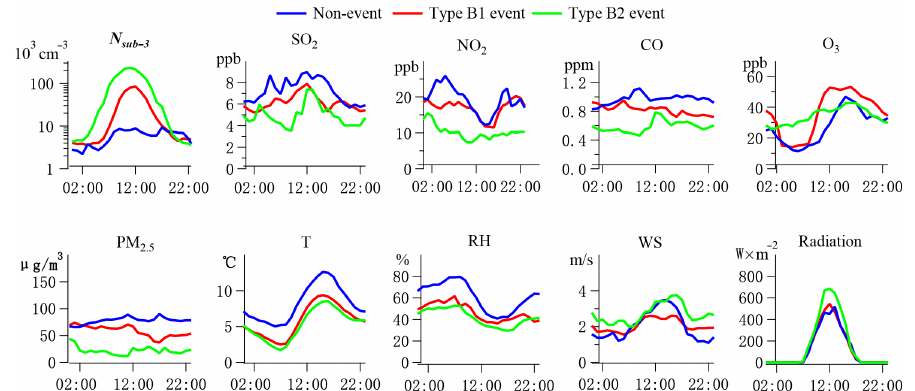
Figure 5. Diurnal variations of mean N sub-3 , anthropogenic trace gases (SO 2 , NO 2 , CO, and O 3 ), PM 2 . 5 , and meteorological variables (temperature, RH, wind speed, and solar radiation flux) on non-event days ( n = 8, blue line) and event days ( n = 3 for Type B1 event, red line and n = 6 for Type B2 event, green line) during winter measurement